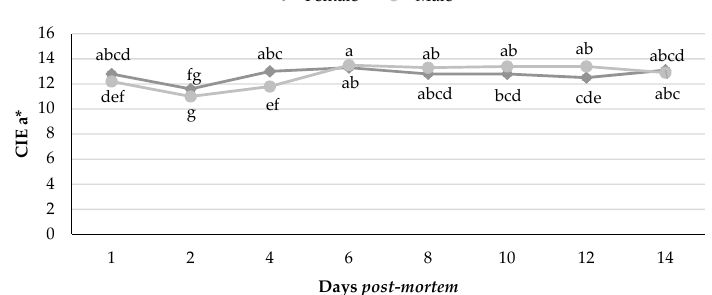
Figure 4. Effect of sex and ageing (days post-mortem ) on the a* values (red-green spectrum) of the surface color of impala longissimus thoracis et lumborum meat from females and males. a–g Means with different superscripts differ from one another ( p ≤ 0.05). Error bars represent the standard error of the means. The interaction ( p < 0.001) between sex and ageing period for the chroma values of impala meat is presented in Figure 5. Female impala had higher chroma values than males on day 1, 2, 4, and 14 post-mortem , while males had higher chroma values than female impala on day 12.